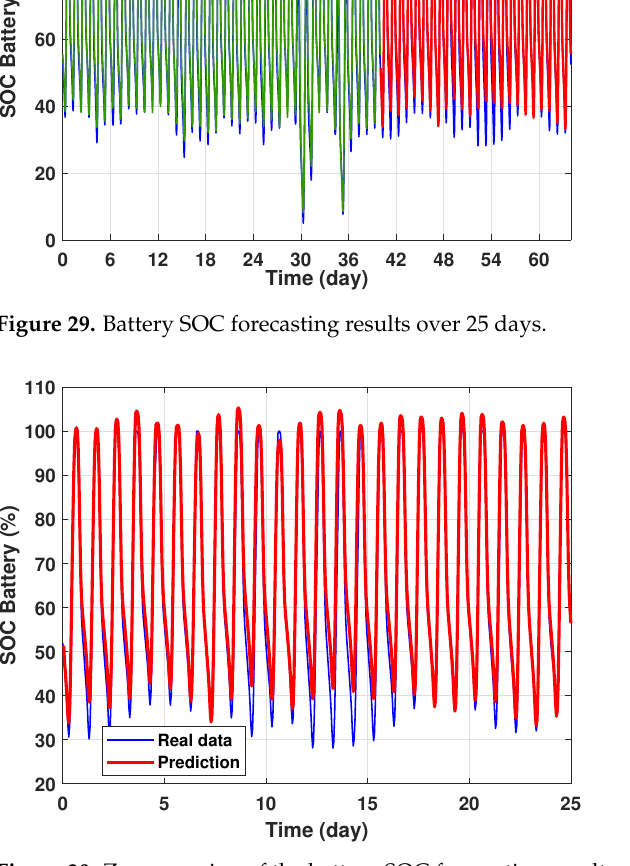
Figure 30. Zoom version of the battery SOC forecasting results over 25 days.